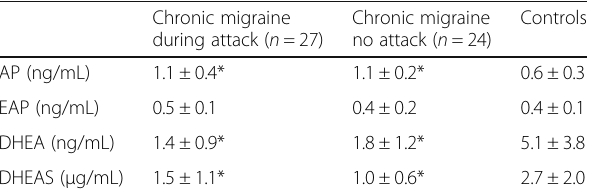
Values are means + S.D. * p <0.05 vs. the respective control groups. No significant changes were found between values obtained during the attack and in the interictal period. Statistical analysis was performed by One-way ANOVA + Fisher ’ s LSD (AP, F 2,79 = 24.79; EAP, F 2,79 = 1.43; DHEA, F 2,79 = 18.06; DHEAS, F 2,79 = 10.66)